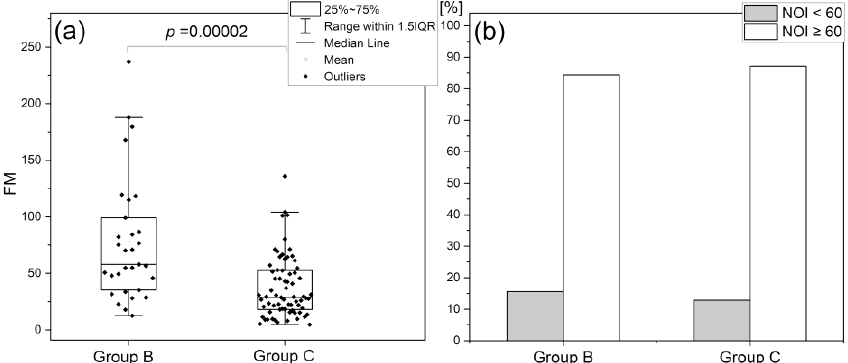
Figure 5. Comparison of the FM ( a ) and NOI ( b ) parameters in groups B – healthy middle-aged indi- viduals, and C – diabetes type-2 patients; the p -value was calculated based on the Mann – Whitney test [46]. Based on: Gebicki J, Katarzynska J, Marcinek A. Effect of psychological stress on microcirculation oscillations: diagnostic aspects. Vasc Health Risk Manag. 2023 , 19 , 79 – 82; DOI:10.2147/VHRM.S399082, Dove Medical Press Ltd.